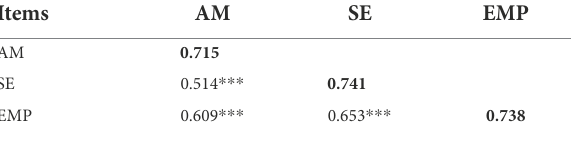
TABLE 2 Discriminate validity of the scale.